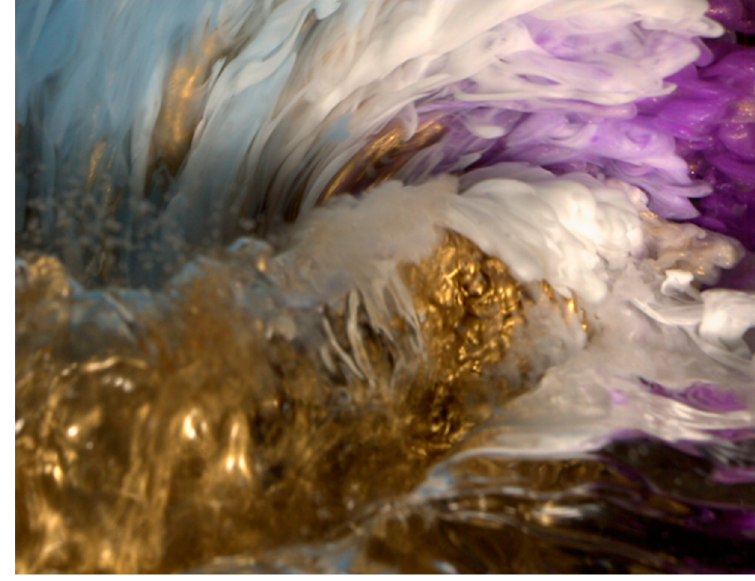
Figure 2. Fluid form captured by a high-speed camera.